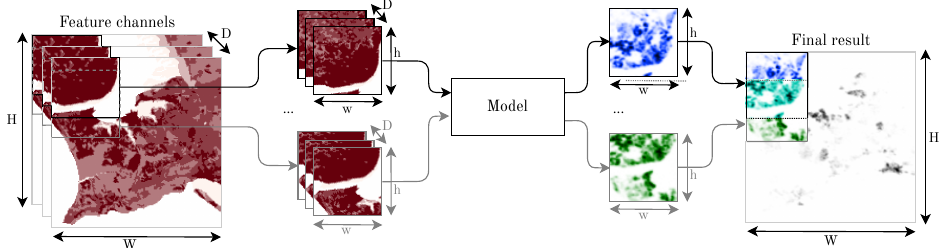
Figure 3. Illustration of the strategy to iteratively convert large spatial inputs into multiple